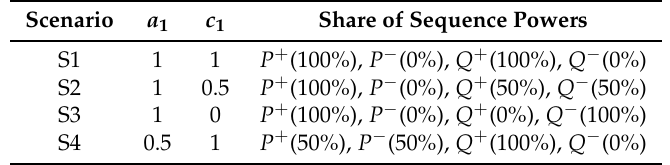
Table 1. Different scenarios of voltage source converter (VSC)1 control strategies.